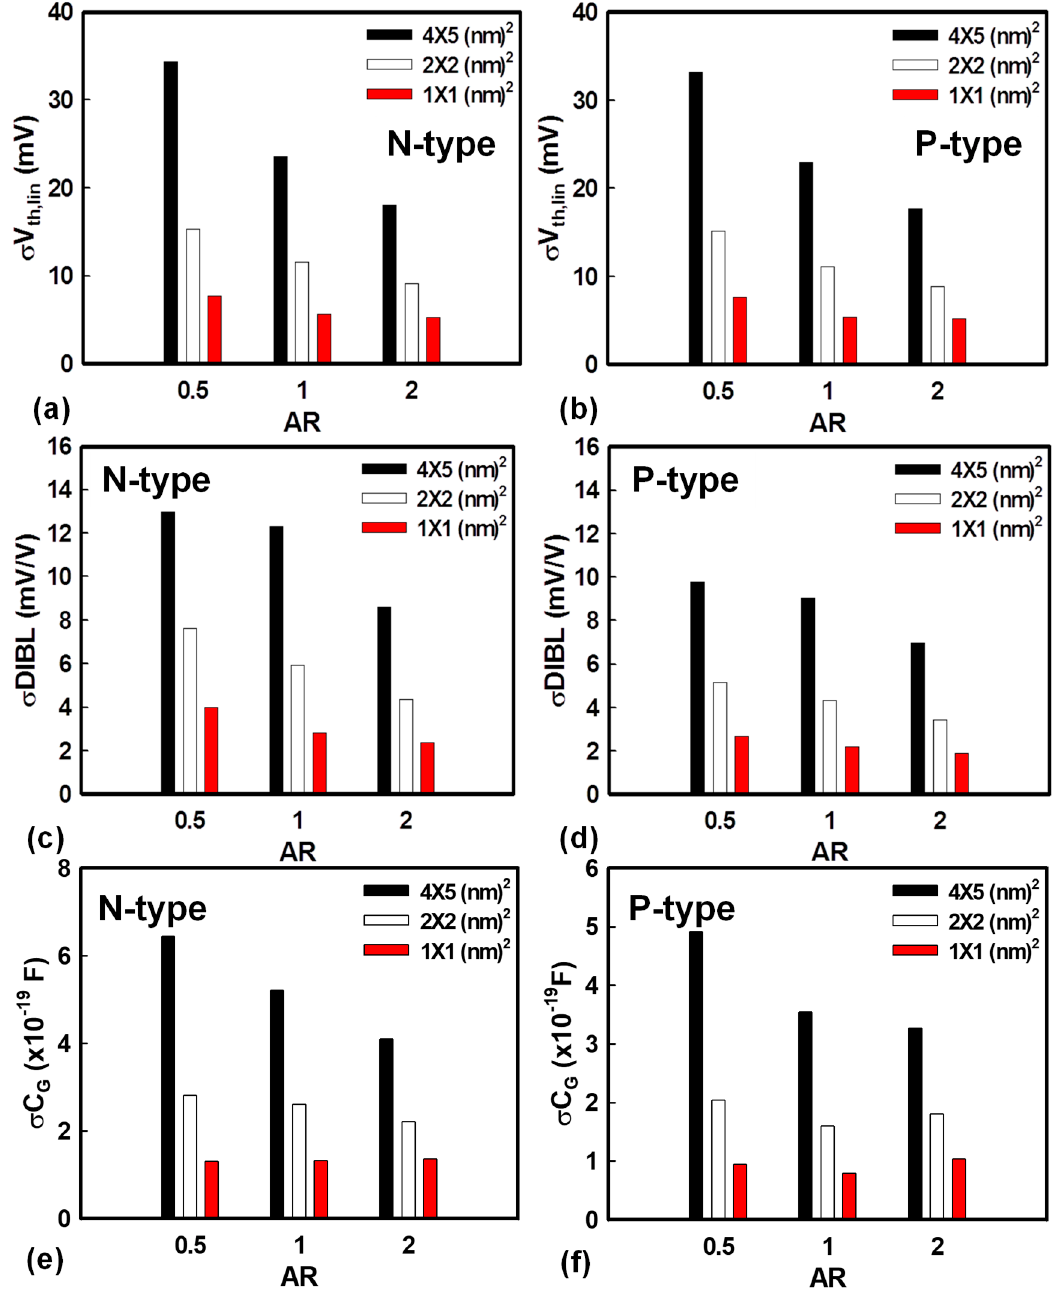
Figure 2. The standard deviation of ( a ), ( b ) V th , ( c ), ( d ) DIBL, and ( e ), ( f ) gate capacitance (CG) versus di ff erent ARs with respect to di ff erent grain sizes of N- / P-type gate-all-around (GAA) nanowire (NW) MOSFETs a ff ected by WKF. For both the N- and P-type GAA NW MOSFETs, devices with a larger grain size and smaller AR have greater deviations than the others.